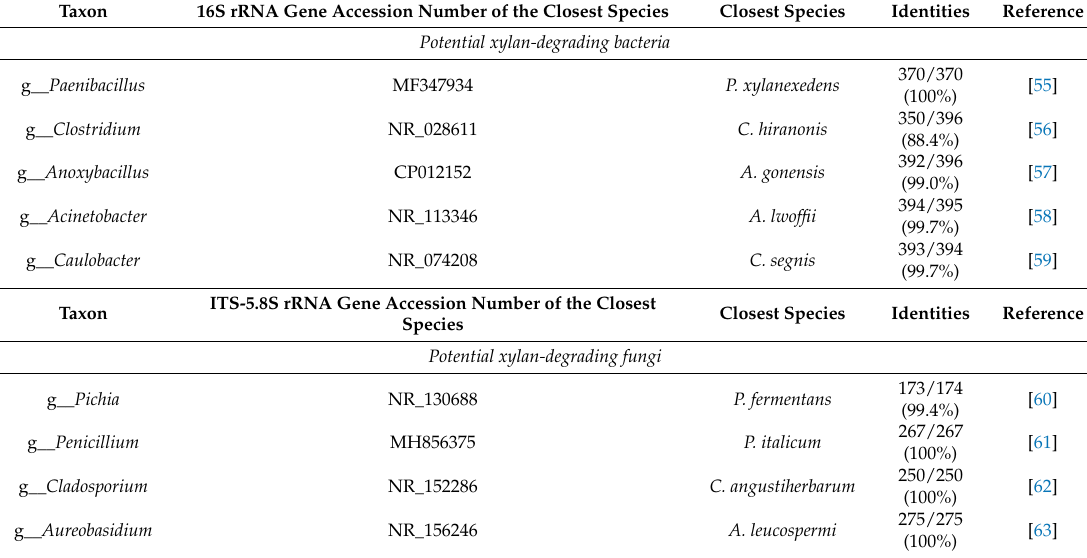
Table 4. Potential xylan-degrading microbiota identified from MiSeq